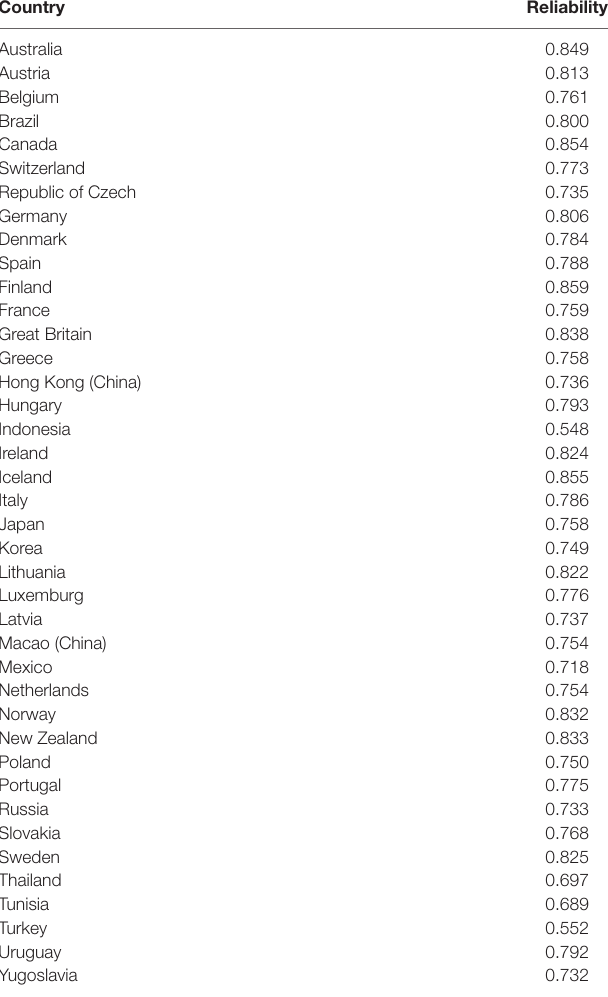
TaBle 1 | Reliability of PISA 2003 school belongingness scale.